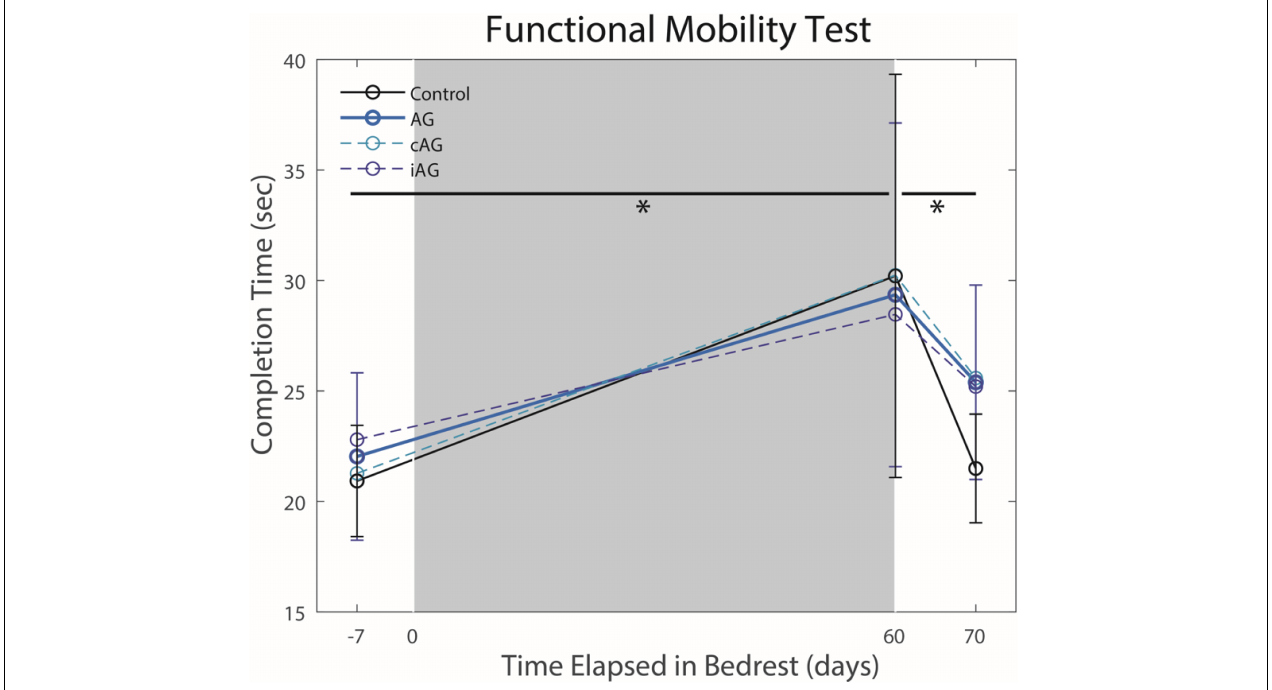
FIGURE 2 | Functional Mobility Test (FMT) performance changes pre- to post-HDBR and post-HDBR recovery. HDBR resulted in a significant increase in completion time ( p = 0.0002) for all subjects regardless of AG group. Completion time recovered to pre-HDBR levels by 10 days post-HDBR ( p = 0.013). Significant differences are noted by